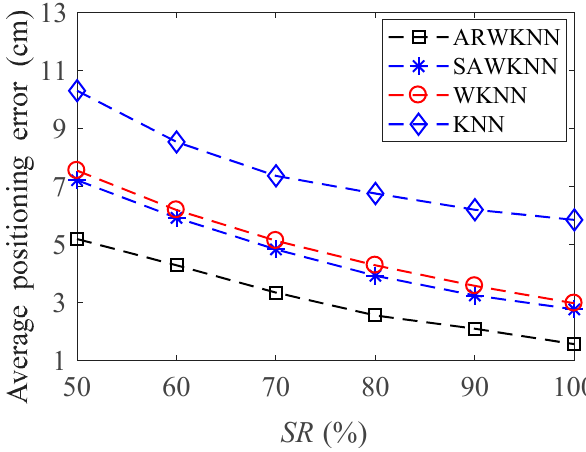
Figure 16. In 2-D, the impact of sampling ratio ( SR ) on the average positioning error with K max = 4.